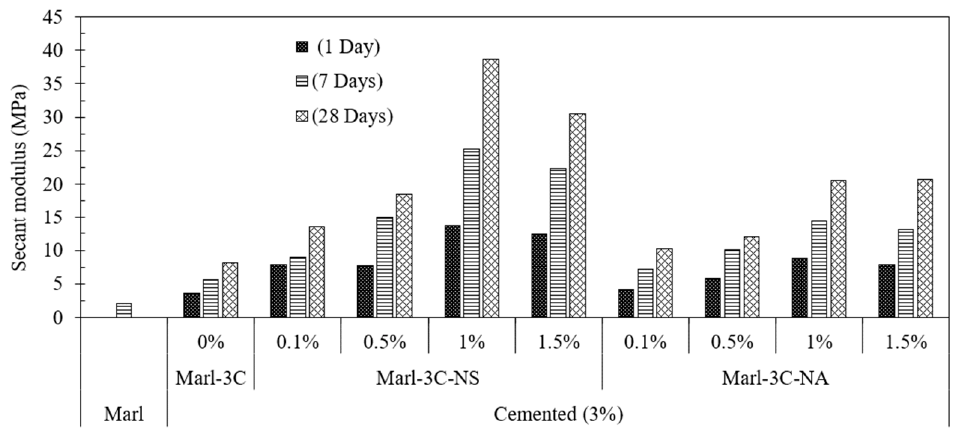
Figure 4. Secant modulus of stabilized marl.